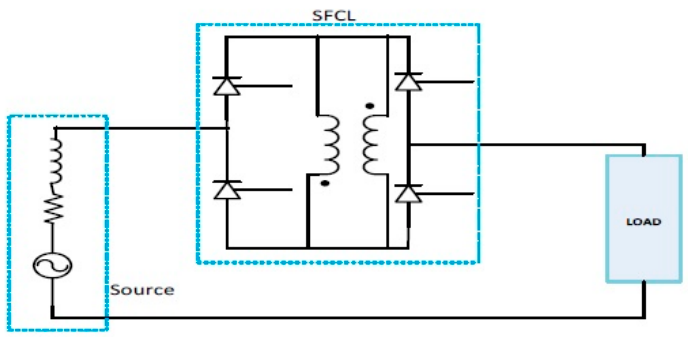
Figure 8. Non-inductive SCFCL in an electrical circuit.